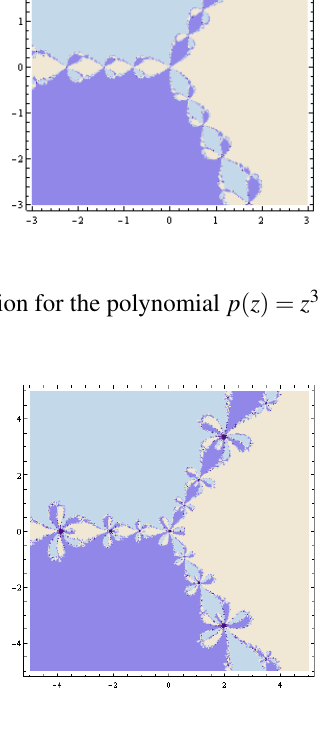
Fig. 2 Basins of attraction for the polynomial p ( z ) = z 3 − 1. Chebyshev’s